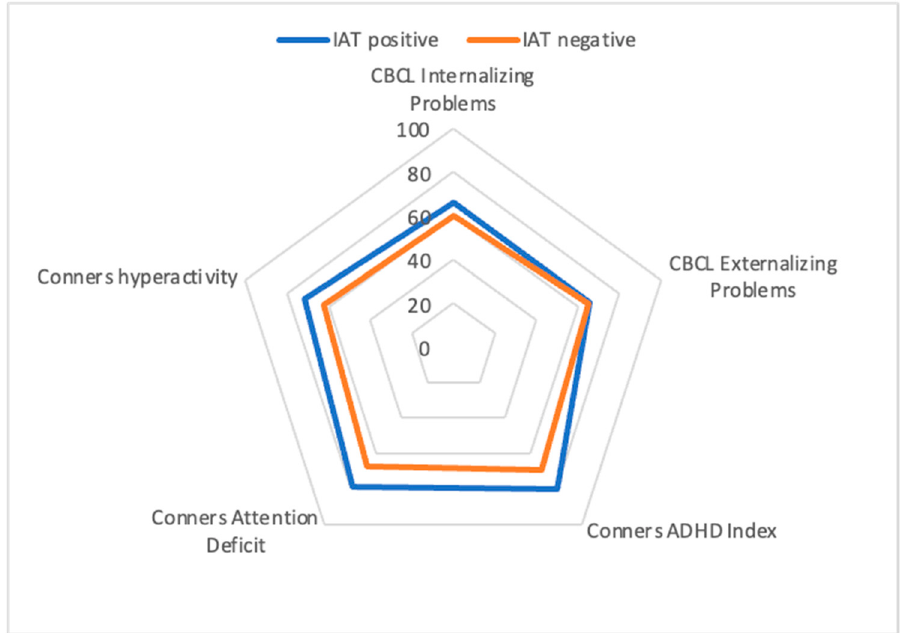
Figure 1. Summary of some of the statistically significant differences in scores between ADHD patients with IAT score ≥ or <50 using the mean scores of Conners’ subscales and CBCL internalizing and externalizing subscales.